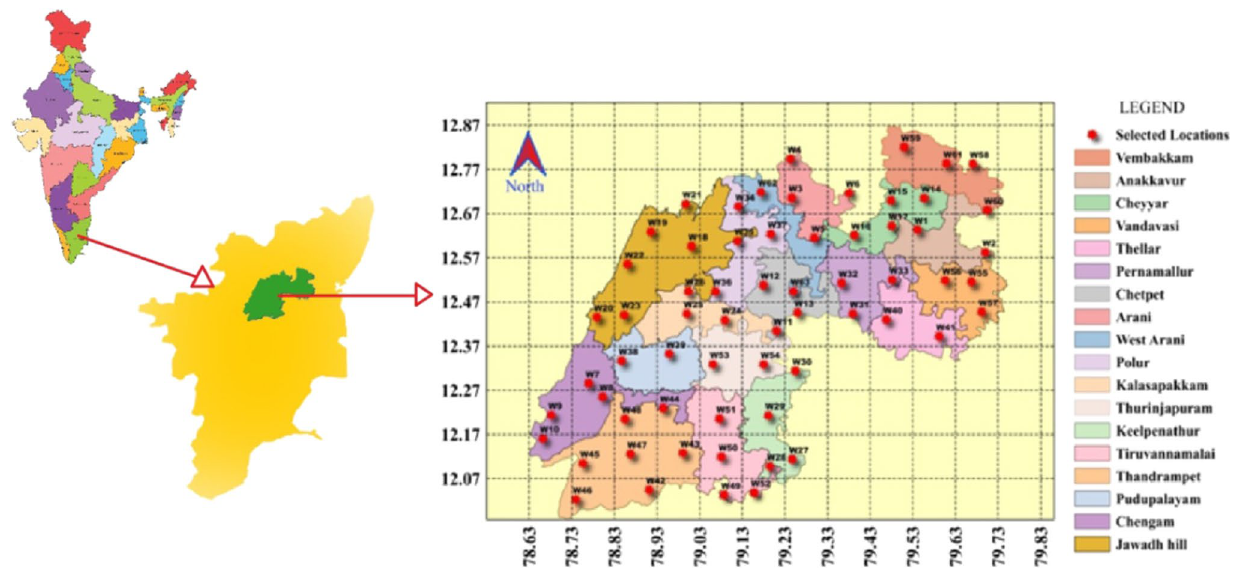
Fig. 1 Location of the study area—Tiruvannamalai District